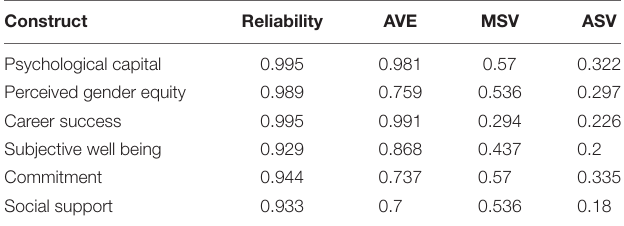
TABLE 4A | Reliability, average variance extracted (AVE), maximum shared variance (MSV), and average variance shared (ASV). Construct